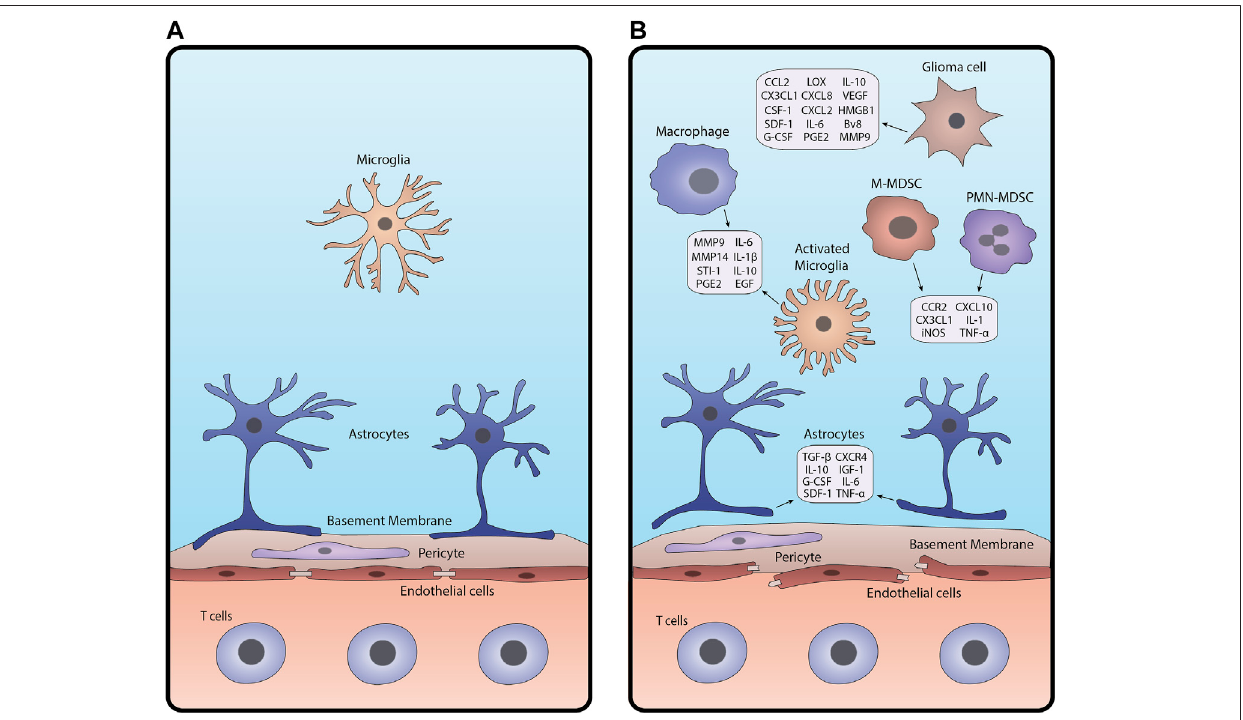
FIGURE 1 | Schematic of the BBB under (A) homeostasis and (B) glioma-associated in fl ammation. In in fl amed conditions (B) , junctions between endothelial cells break apart, pericytes are disrupted, and astrocytic endfeet detach from the basement membrane. Glioma cells, macrophages and microglia, astrocytes, and MDSCs release cytokines and other factors that contribute to BBB breakdown and create an in fl ammatory tumor